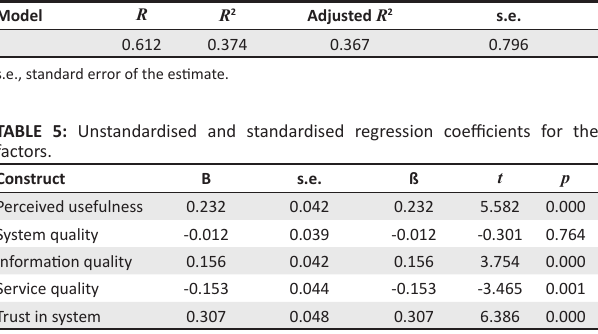
TABLE 4: Summary showing the success of the research